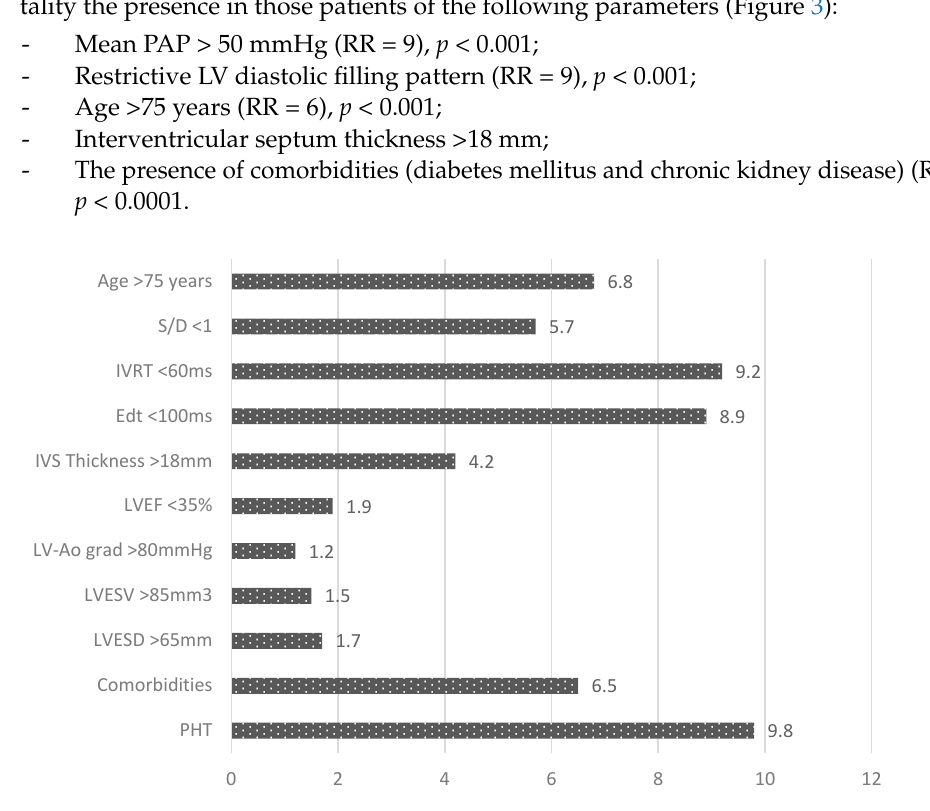
Figure 2. Relative risk for cardiovascular complications and early postoperative death depending on the presence of pulmonary hypertension.